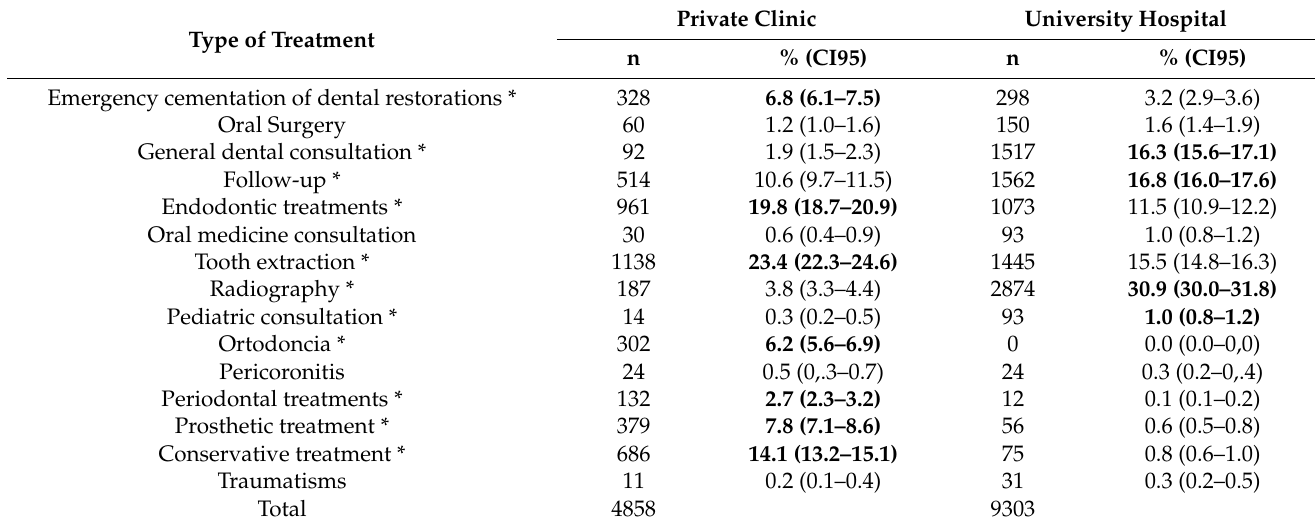
Table 2. Distribution of dental treatments performed in pandemic period (March–June 2020) accord- ing to dental care